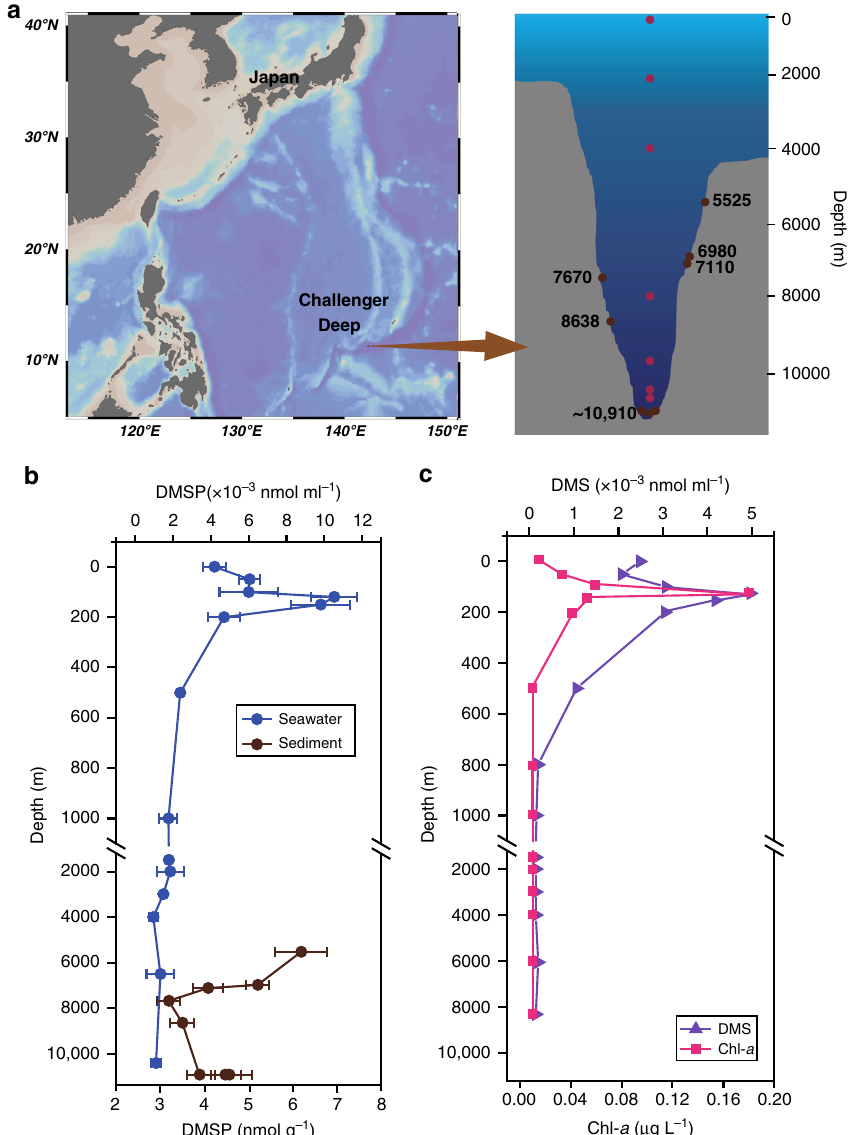
Fig. 1 Depth pro fi le of DMSP, DMS, and chlorophyll a in Challenger Deep seawater and sediment samples. a Sampling sites and depths. b Total DMSP concentrations in seawater and sediment samples. c Total DMS and chlorophyll a in seawater samples. Data in b are presented as means ±